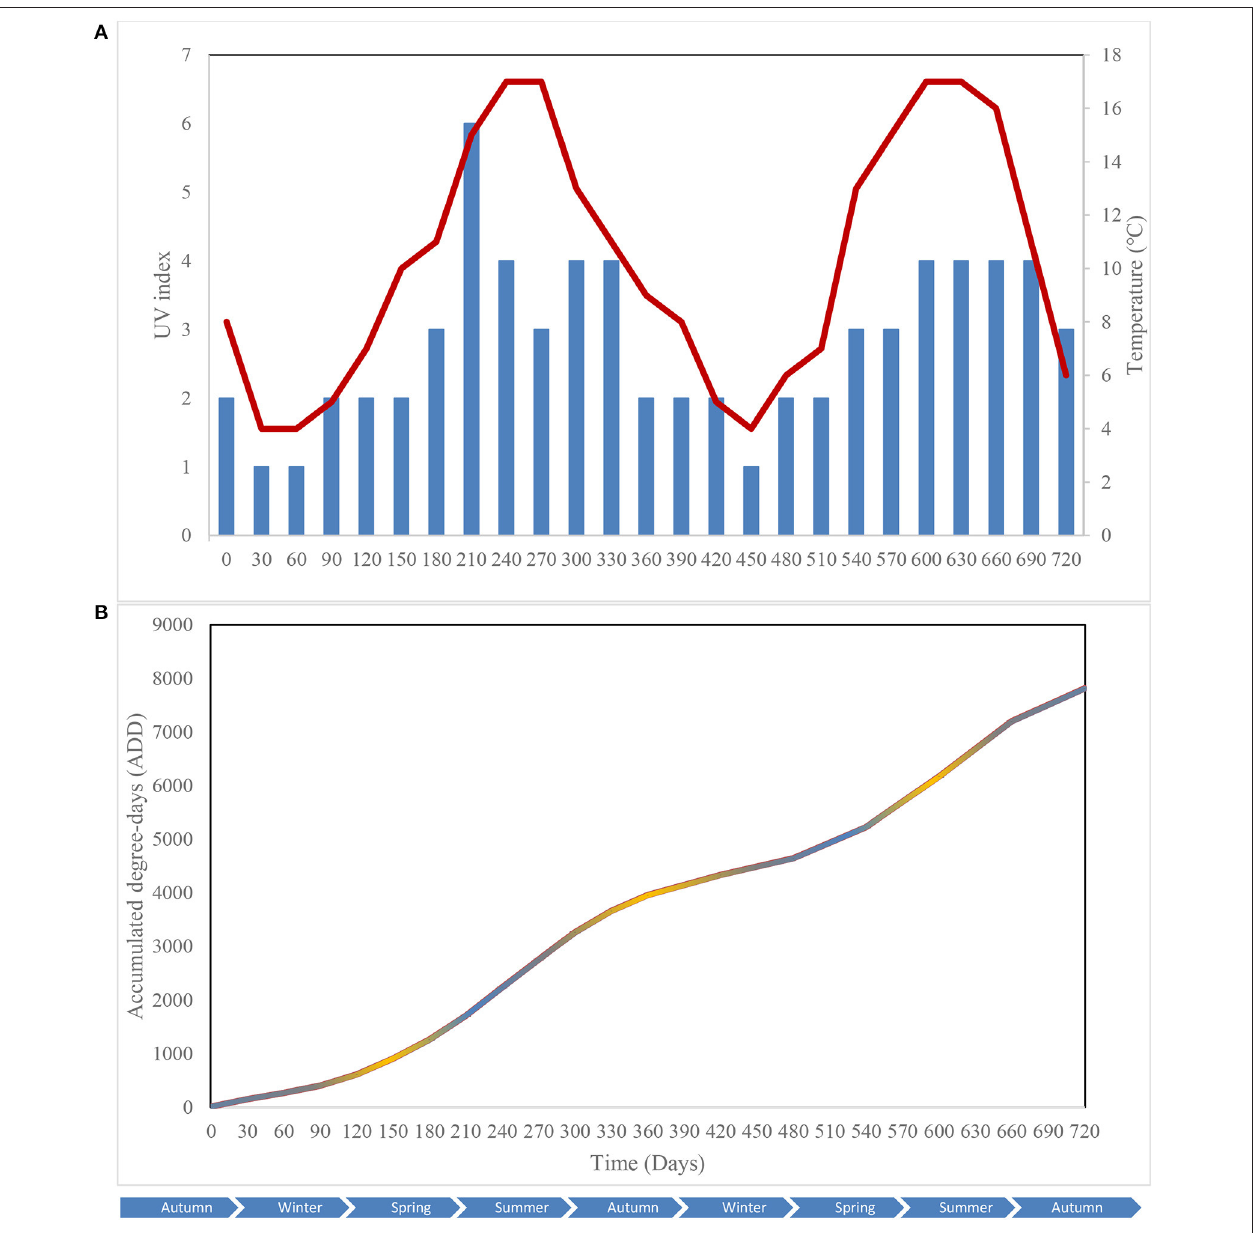
FIGURE 1 | Atmospheric temperature ( • ) and UV index ( (cid:4) ) at the study site (A) ; Accumulated degree-days (ADD) of the control ( • ), leaf litter ( • ) and S. scrofa domesticus ( • ) treatments during a 720-day in situ study (B) . Each data point is the mean of triplicate samples.